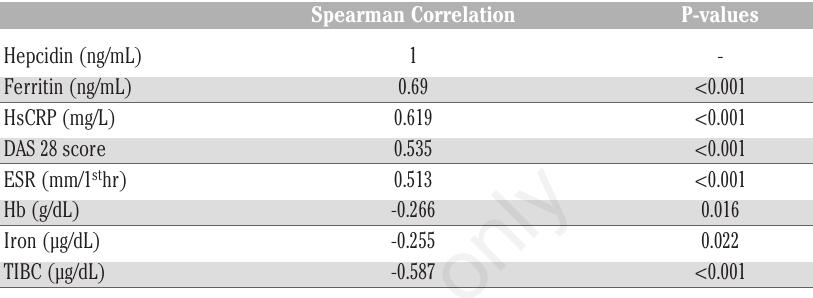
Table 5. Correlation of serum hepcidin with some variables in 51 RA